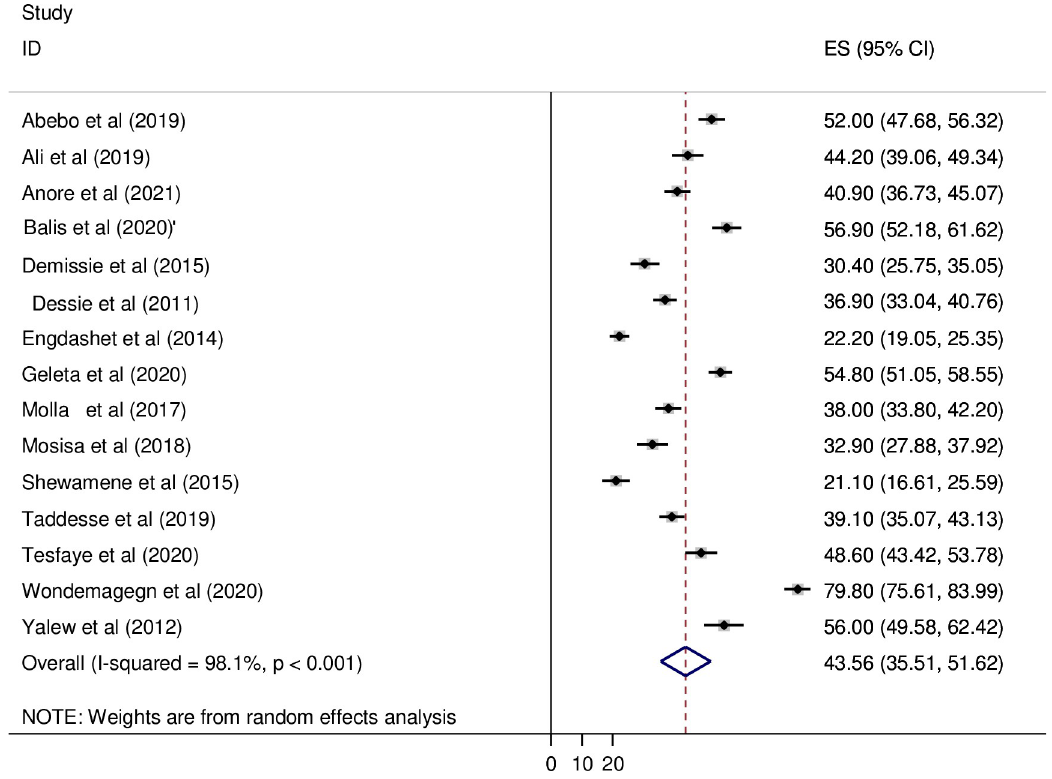
Fig 2. Forest plot revealing the overall pooled prevalence of the risky sexual practice in Ethiopia.